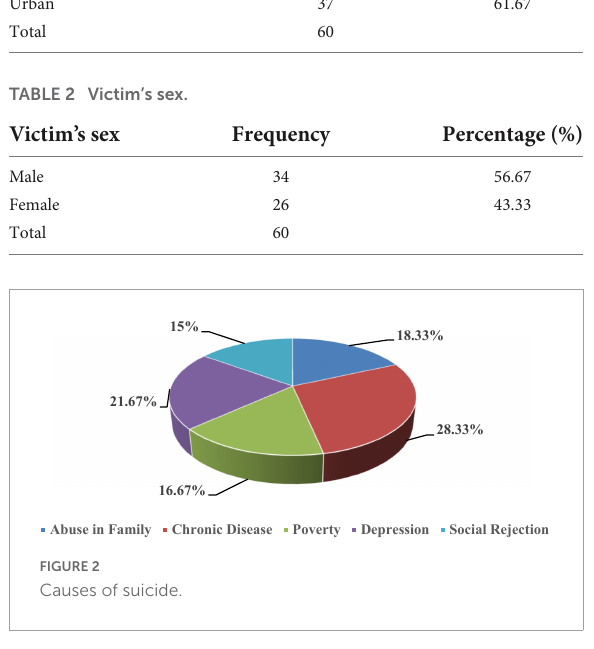
Abuse in Family Chronic Disease Poverty Depression Social Rejection FIGURE2 Causes of